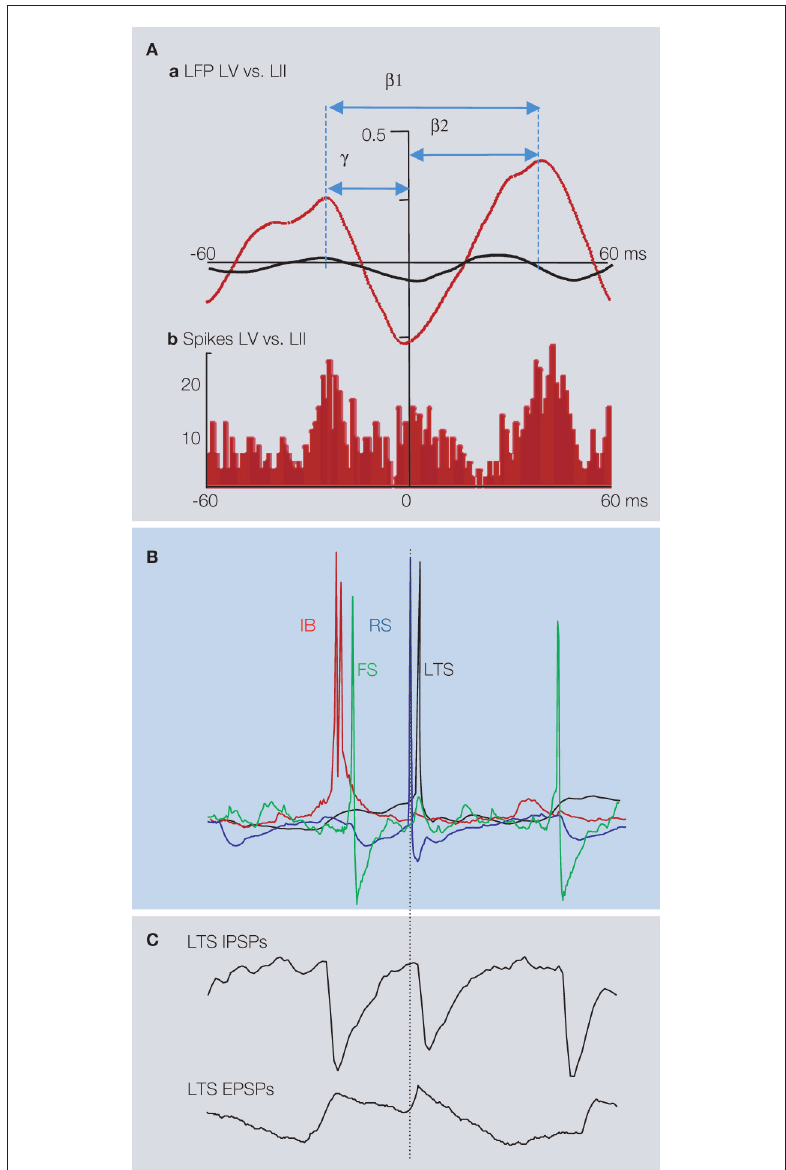
Figure 4 | A mechanism underlying period concatenation of superficial γ1 and deep γ2 cortical rhythms. (A) (a) The principal feature of the β 1 rhythm as a concatenation sum of co-expressed γ 1 and β 2 rhythms is an asymmetric cross correlogram when comparing local field potential (LFP) activity in superficial (LII) and deep (LV) cortical laminae. Prior to concatenation, cross correlogram of γ 1 and β 2 rhythms is almost flat (black line). During the β 1 rhythm correlation peaks are separated by 65 ms (one period of the LFP rhythm). However, peak lead and lag, relative to 0 ms, are 25 and 40 ms – one period of the γ 1 and β 2 rhythms respectively (red line). This asymmetric relationship is also manifest in relative spike times. The histogram (b) shows the distribution of LV intrinsically bursting neuronal units relative to single units from LII neurons. (B) Representative neuronal activity patterns in four major cell types all aligned to the peak of the concurrently recorded LFP. In the sequence covering a single β 1 period the initial spike generation is in LV intrinsically bursting neurons (IB, red). This is rapidly followed by spiking in superficial fast-spiking interneurons (FS, green). Approximately one gamma period later a spike is generated on the rebound of the superficial layer regular spiking neuron (RS, blue), rapidly followed by a spike from the LIII low threshold spiking neurons (LTS, black). Following approximately one β 2 period the sequence repeats. (C) The concatenation sequence is readily observable in synaptic inputs to individual LTS neurons. Both excitatory postsynaptic potentials (EPSPs) and inhibitory postsynaptic potentials (IPSPs) occur with interevent intervals that alternate between one γ 1 and one β 2